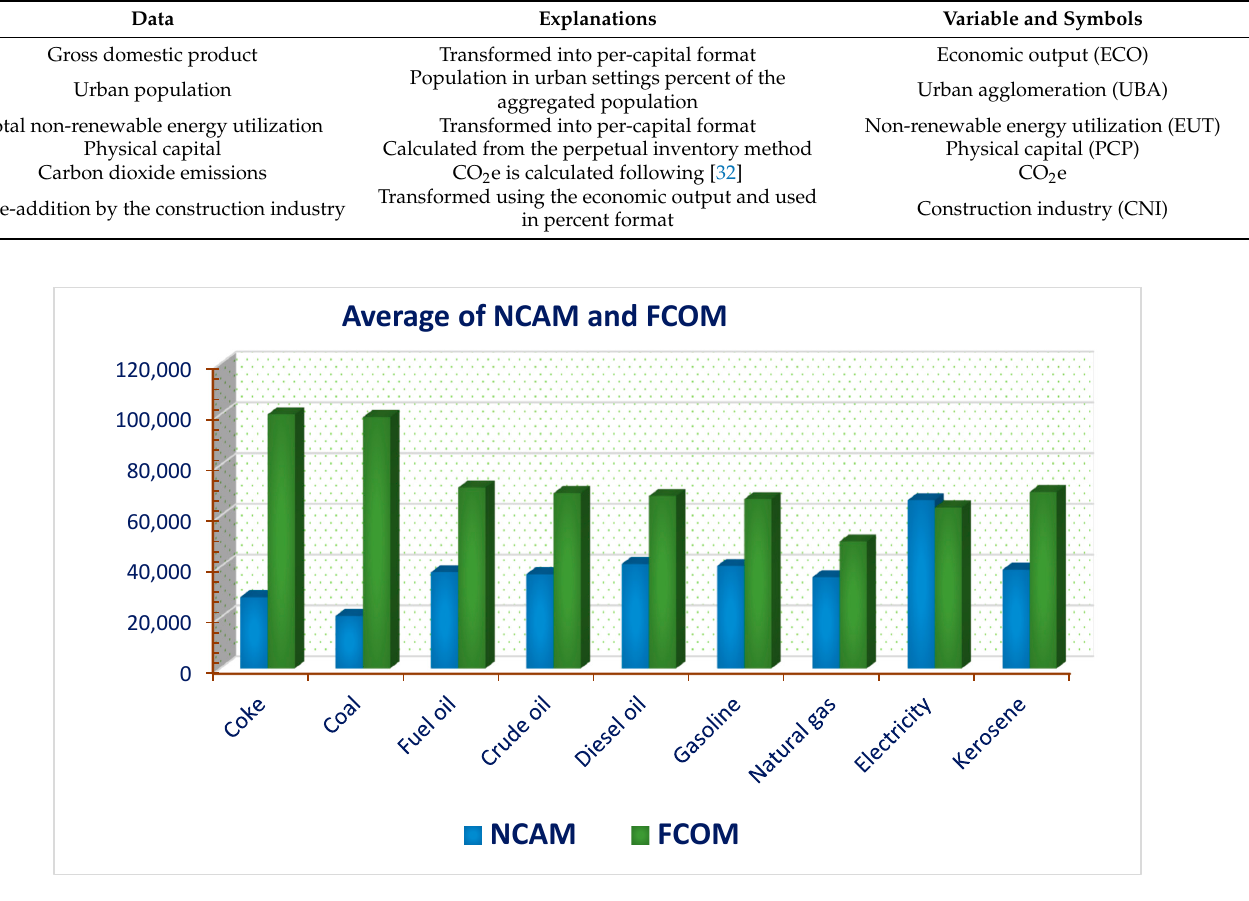
Figure 1. Average of NCAM and FCOM for energy products. Source: Authors’ calculations based on China Energy Statistical Yearbooks (2003–2019).